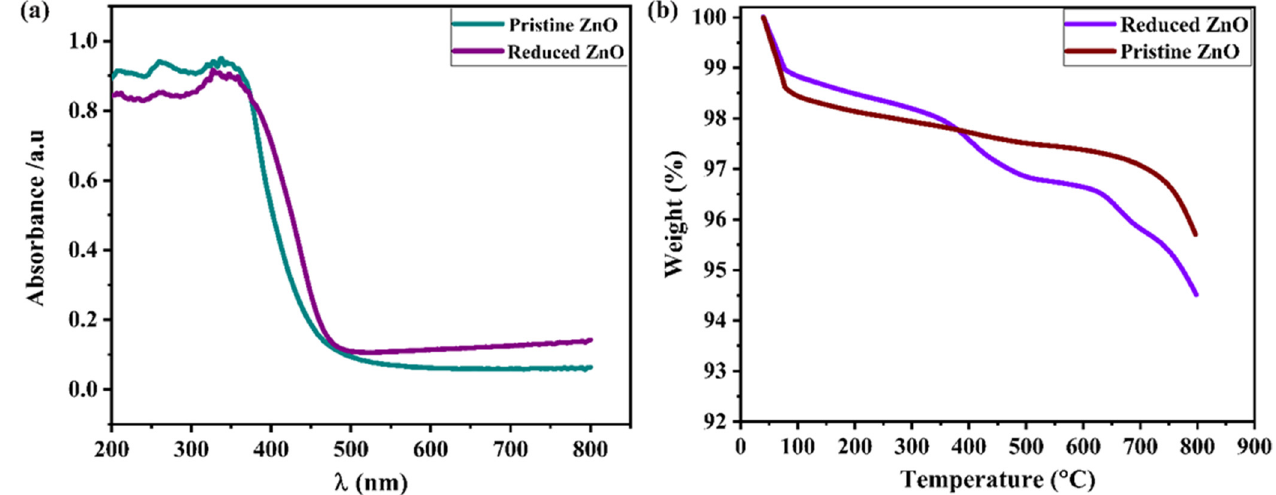
Figure 6. ( a , b ) UV–visible and TGA spectra of as-synthesized ZnO and reduced ZnO powders, respectively.